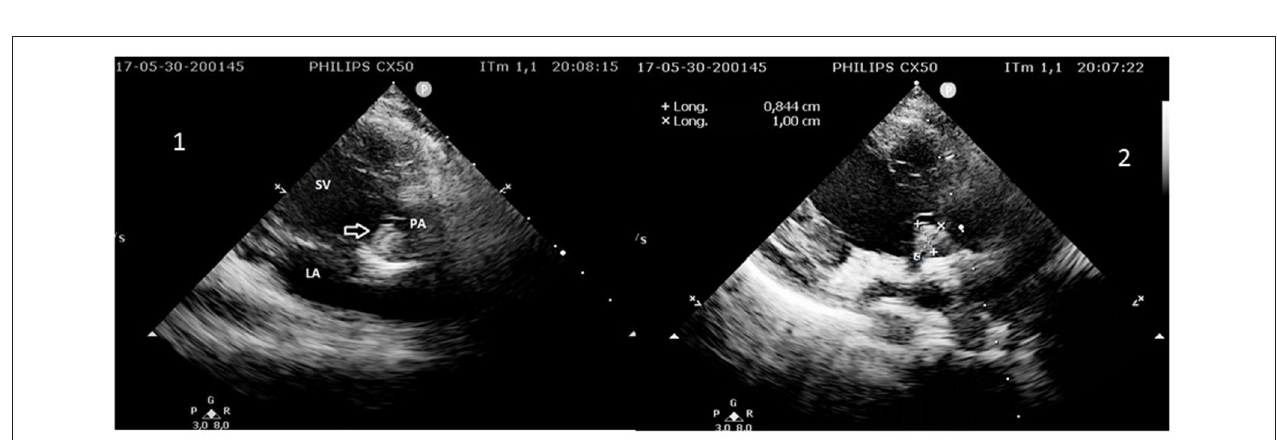
FIGURE 2 | 1. 2D echocardiography showing the mobile thrombus (arrow) inside the pulmonary artery (PA) trunk arising from the single ventricle (SV). LA, left atrium. 2. Measurement of the thrombus in the pulmonary artery (PA) trunk arising from the single ventricle (SV).